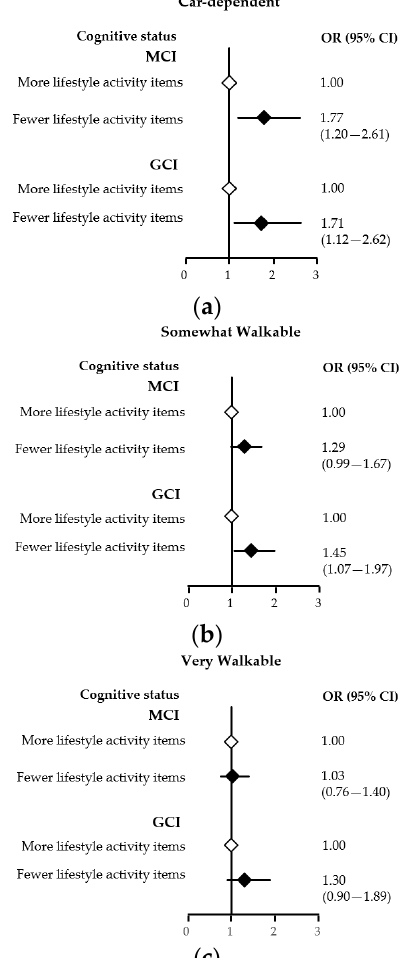
Figure 2. Forest plot showing adjusted associations between neighborhood amenities status and lifestyle activity items and cognitive status in a sample of older adults. CI: confidence interval; GCI: global cognitive impairment; MCI: mild cognitive impairment; OR: odds ratio. The car-dependent group ( a ), the somewhat walkable group ( b ), and the very walkable group ( c ) are shown. The group with fewer lifestyle activity items (hollow diamonds) and the group with more lifestyle activity items (solid diamonds).